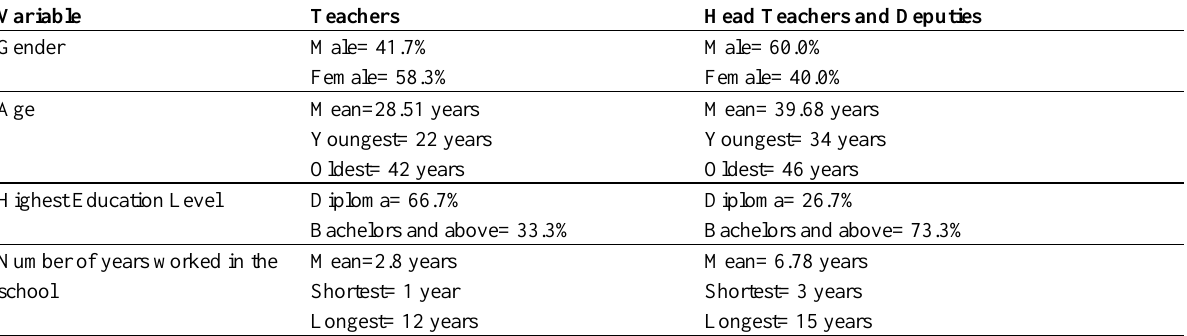
Table 3: Demographic Characteristic of Respondents